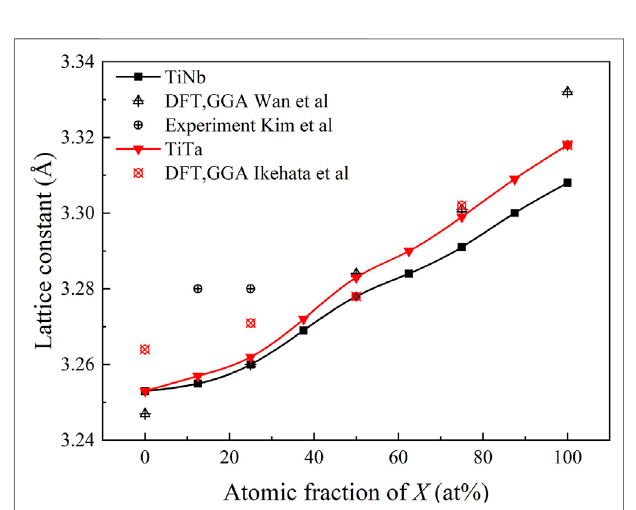
FIGURE 2 | Lattice constants (Å) of β -Ti X ( X = Nb, Ta) alloys. (Wan et al., 2014) (Kim et al., 2006); (Ikehata et al., 2004)